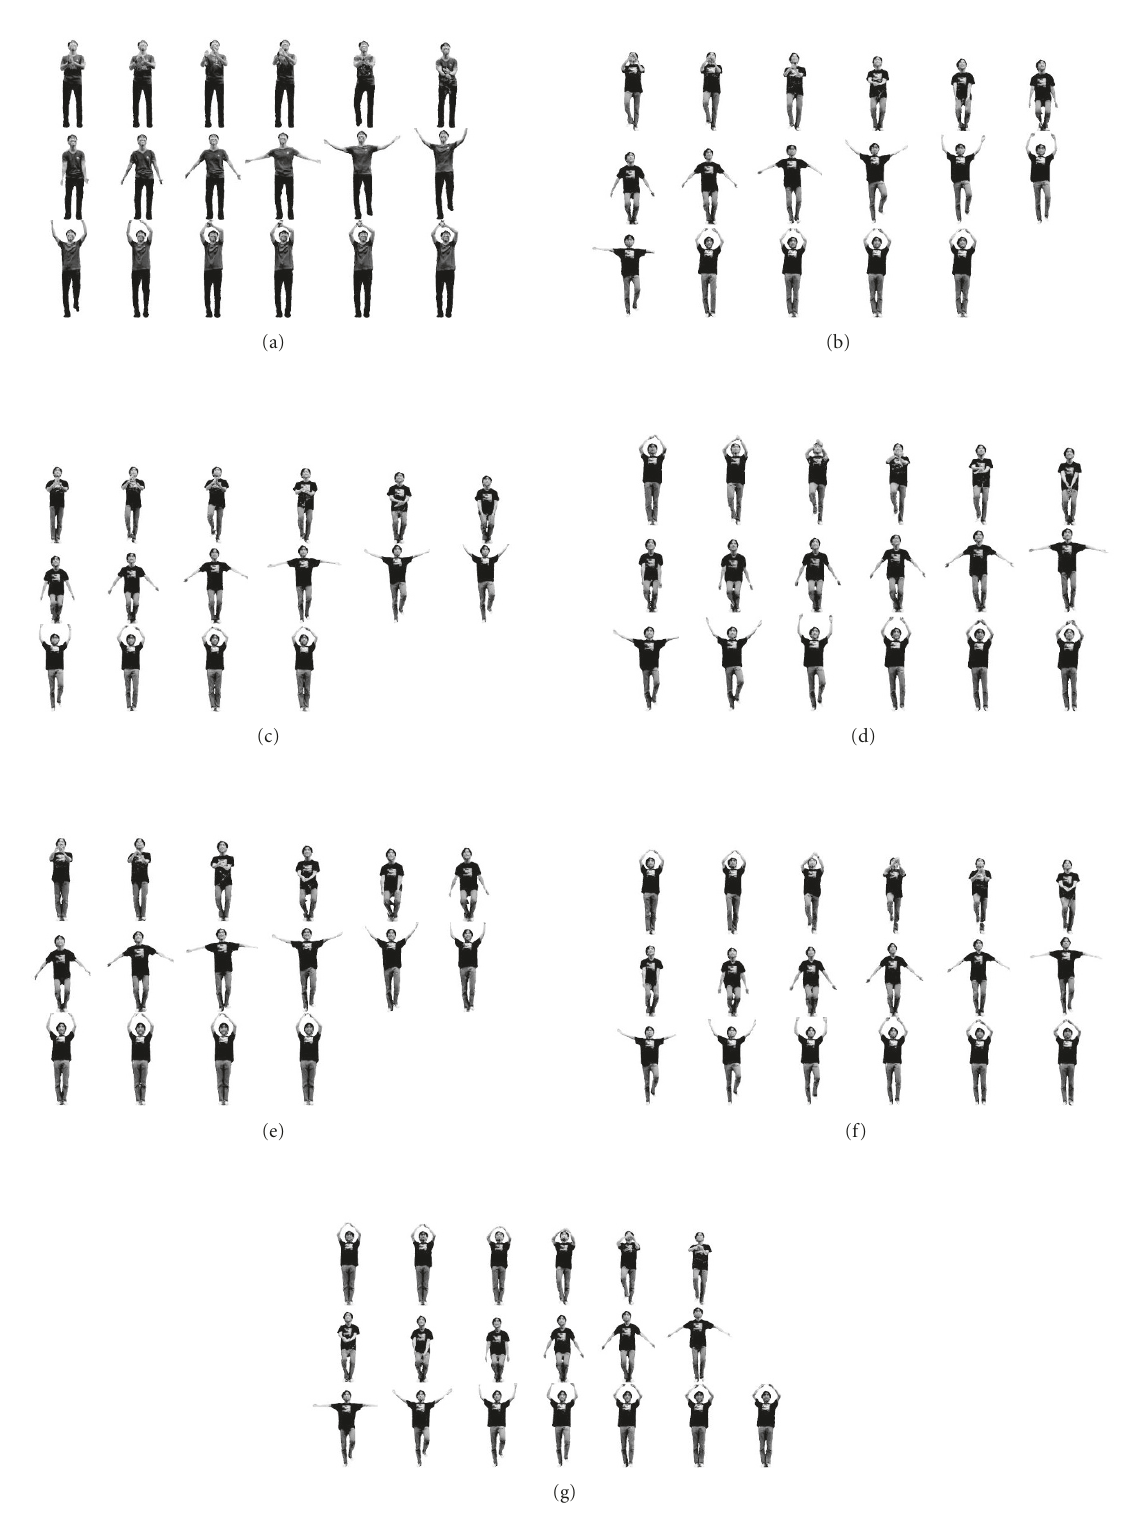
Figure 11: Experimental results for 3D video retrieval using motion of “drawing a big circle by hands”: (a) query clip from sequence #2-2 (clip #2-2 (4) ); (b) the most similar clip in sequence #2-1 (clip #2-1 (4) ); (c) the second most similar clip (clip #2-1 (28) ); (d) the third most similar clip (clip #2-1 (5) ); (e) the fourth most similar clip (clip #2-1 (16) ); (f) the fifth most similar clip (clip #2-1 (29) ); (g) the sixth most similar clip (clip #2-1 (17)